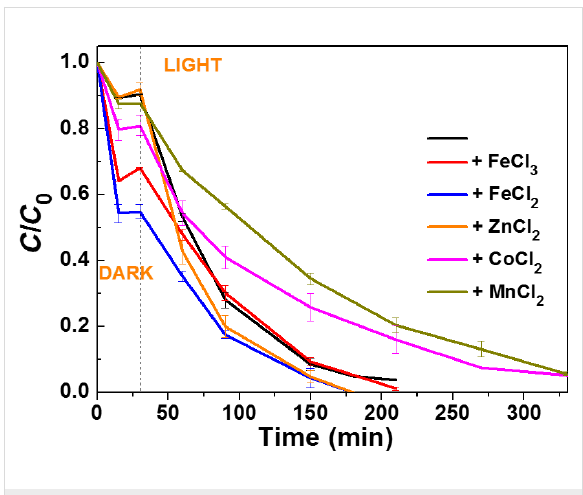
Figure 7: Influence of some transition metal chlorides used at 100 µM concentration on the photocatalytic efficiency of the ZnO/ZCIS catalyst (the black curve corresponds to the reference photocatalytic test).